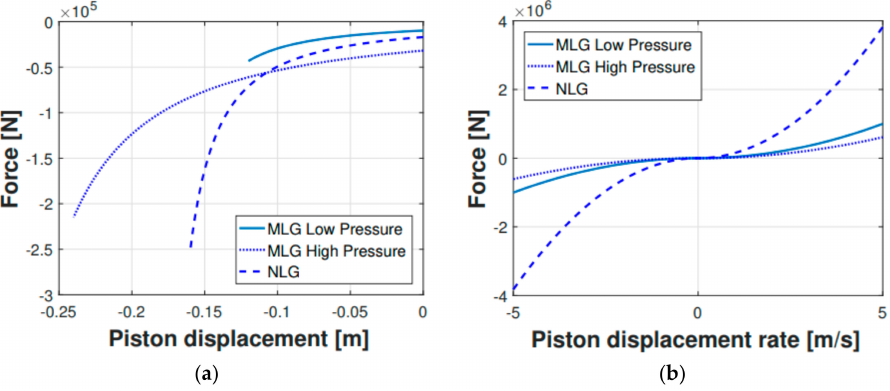
Figure 5. Shock absorbers elastic ( a ) and damping ( b )